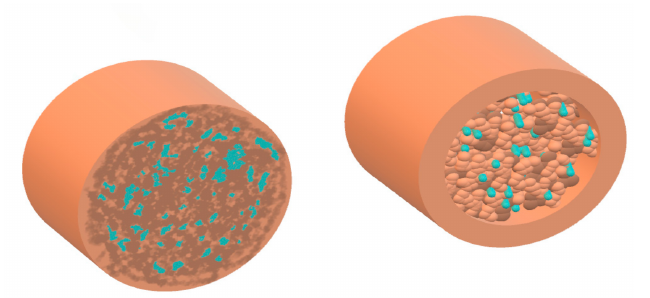
Figure 4. Pore distribution schematic diagram. Blue areas represent the water-filled